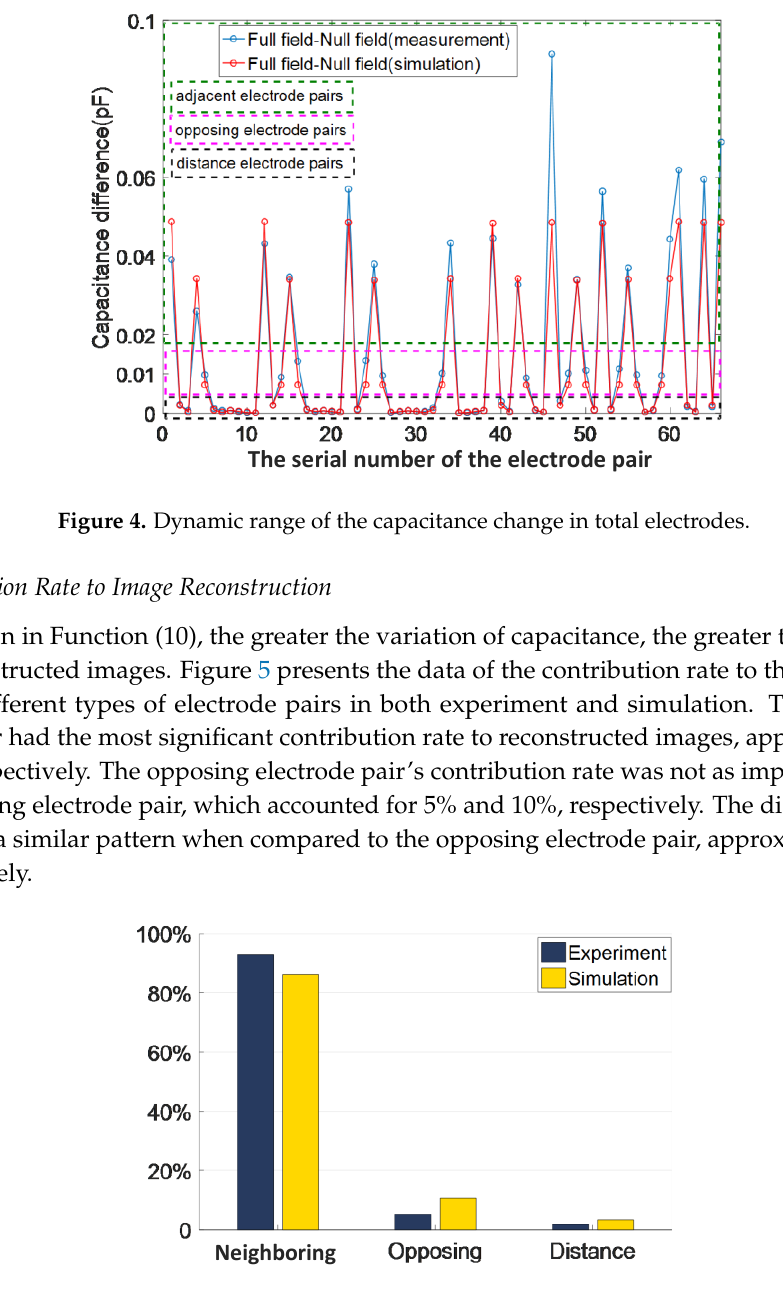
Figure 5. Contribution rate of neighboring, opposing, and distance electrode pairs to image reconstruction.